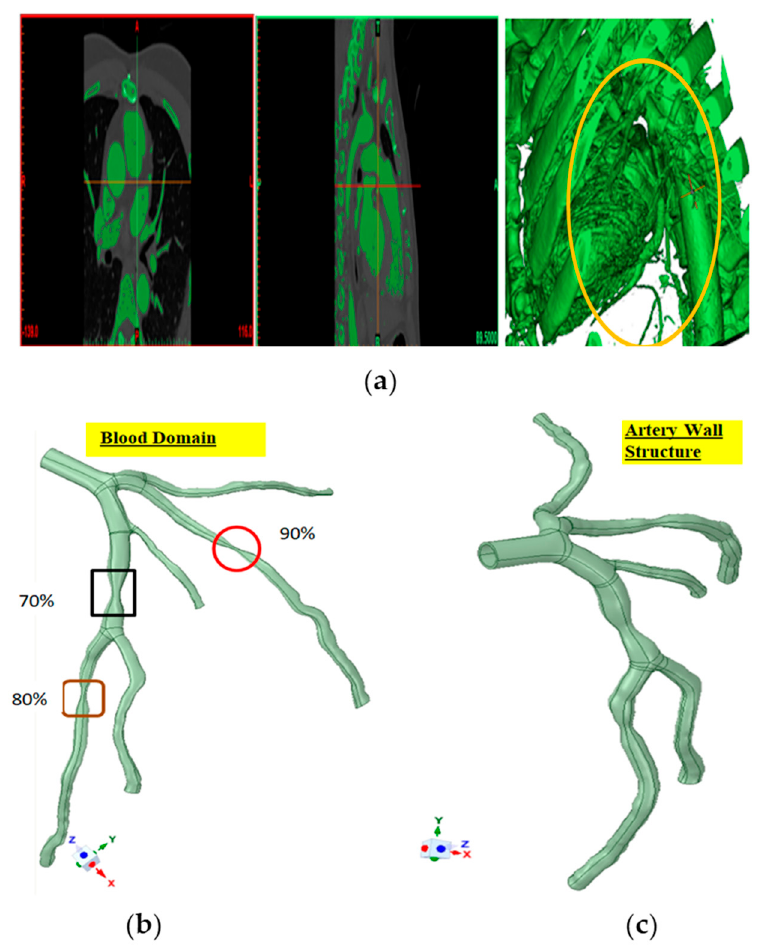
Figure 1. ( a ) Computed Tomography (CT) images left, right, posterior, interior, and volume rendering image with actual location of the left coronary artery (LCA). ( b ) Stereo-lithography (.stl) model obtained from MIMICS software. ( c ) Artery wall structure developed in ANSYS.